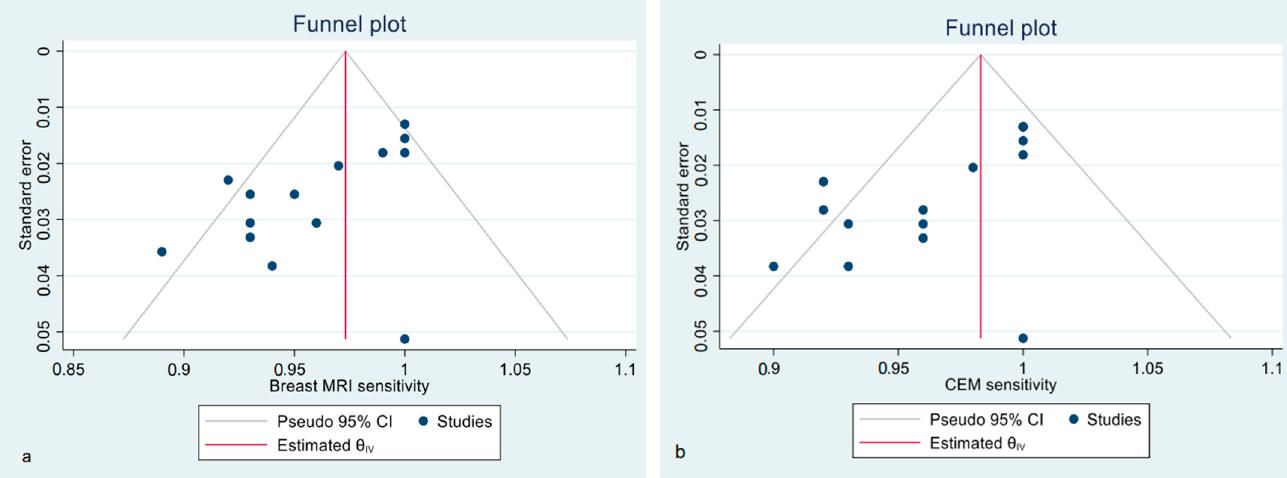
Figure 5. Funnel plot with 95% CIs for publication bias assessment of the pooled sensitivity of CE-MRI ( a ) and CEM ( b ) for the detection of pathological breast index lesions.